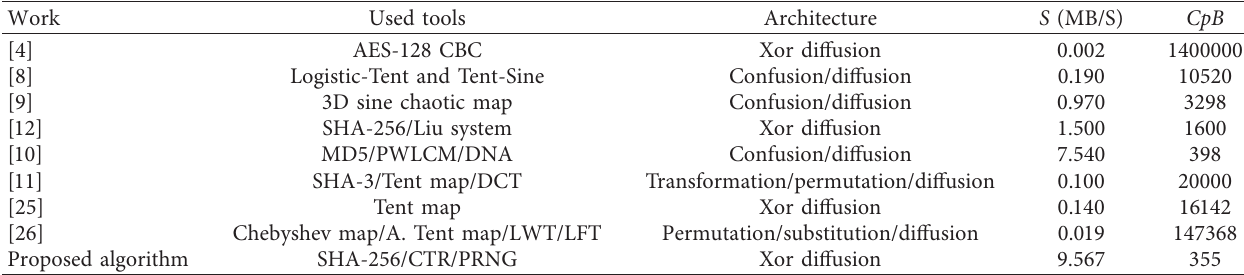
Table 11: Comparative study of encryption algorithm